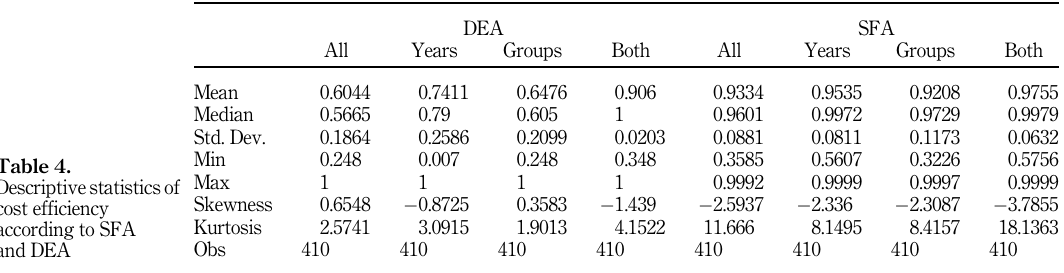
Table 3. The mean cost efficiency scores under the SFA method